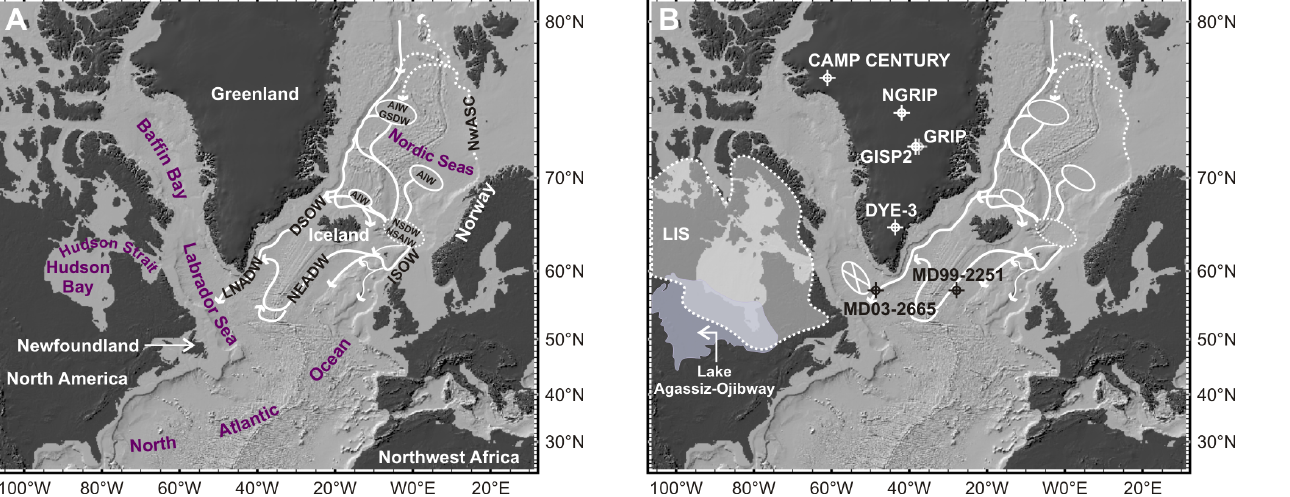
Figure 2a. Intermediate/deep-convection sites in the modern Nordic Seas are marked by ellipses. The one in dotted line is only a buffer region for ISOW (Hansen and Østerhus, 2000). GSDW: Greenland Sea Deep Water. NSDW: Norwegian Sea Deep Water. AIW: Arctic Intermediate Water. The modern deep circulation in the Nordic Seas and the northern North Atlantic is also shown (Hansen and Østerhus, 2000). DSOW: Denmark Strait Overflow Water. ISOW: Iceland–Scotland Overflow Water. NEADW: North- east Atlantic Deep Water. LNADW: Lower North Atlantic Deep Water. The white dotted arrows indicate the northernmost reaches of the NwASC (see Fig. 1a). The base map (identical in Fig. 2a–b) was generated by GeoMapApp © 3.3.0 (Ryan et al., 2009).